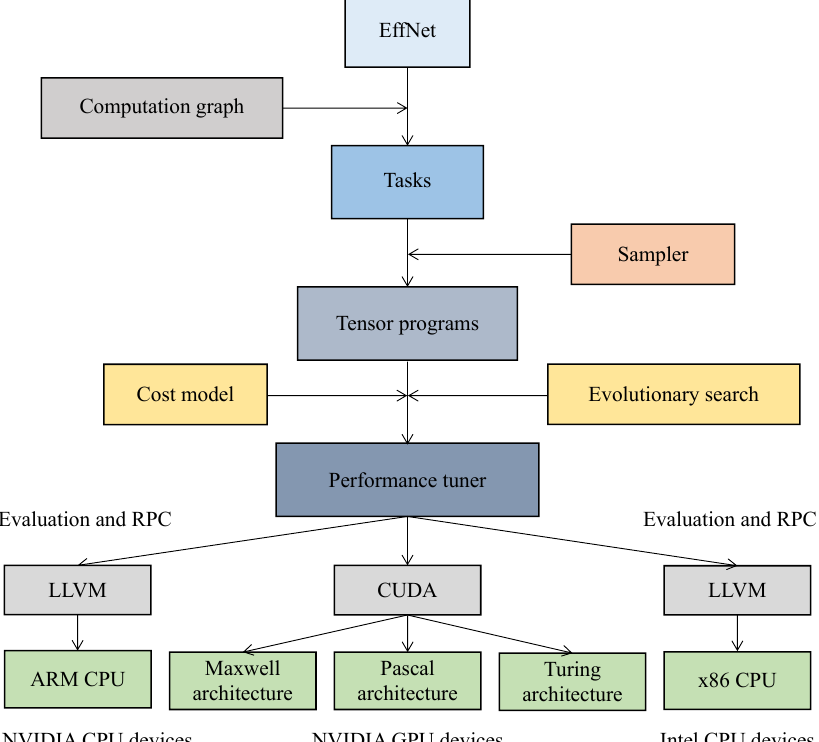
Figure 6. Accelerating recognition of point